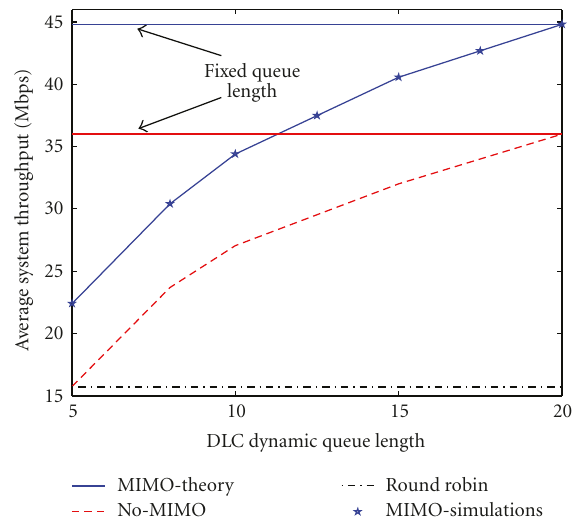
Figure 3: System average throughput for a variable DLC queue length.